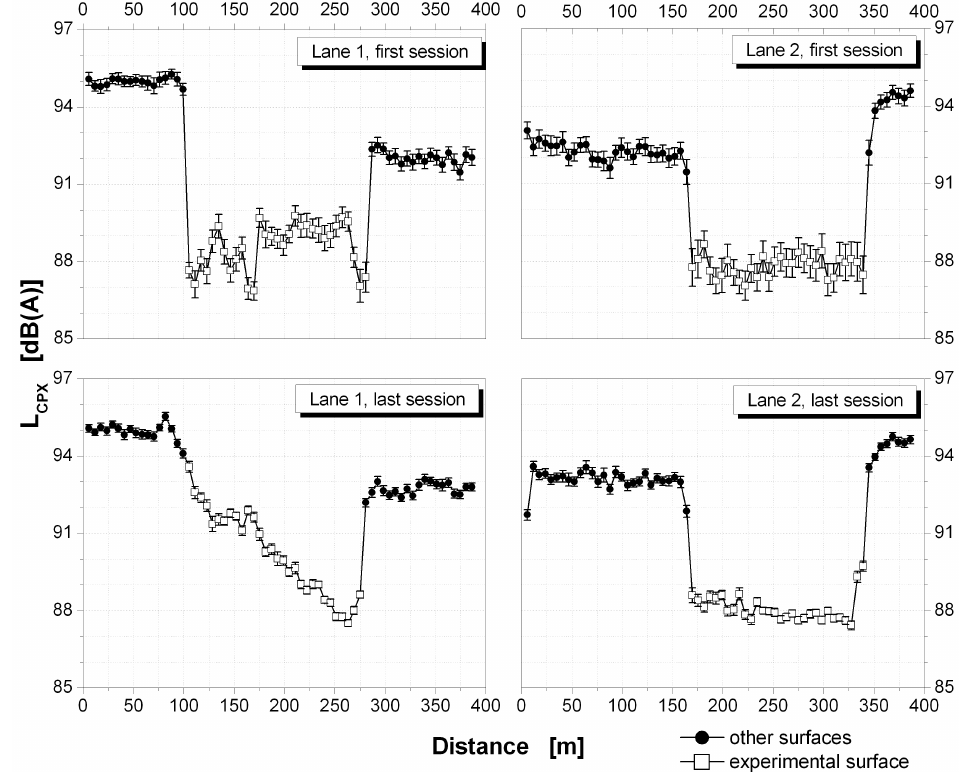
Figure 4. CPX data spatial distribution obtained during first session (upper figures) of measurements and during last one (lower figures) at Site 1. Lane 1 results are represented on the left plots while lane 2 ones are on the right plots. Experimental stretches data are marked with white squares.